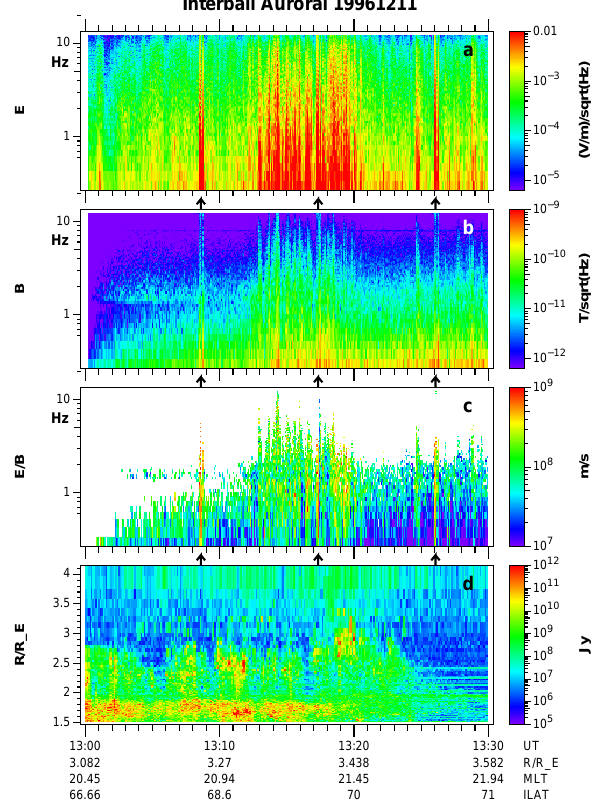
UT1.522.533.54 E R _ R / Fig. 8. Dot-AKR example event 11 December 1996 with IESP and POLRAD data, showing ( a ) electric IESP wave amplitude, ( b ) magnetic IESP wave power, ( c ) the E/B ratio from IESP and ( d ) POLRAD AKR data. Artificial signals are shown by arrows. The intensity in panel (d) is in Jansky (1 Jy = 10 − 26 W m − 2 Hz − 1 ). The vertical axis in panel (d) is the radial distance corresponding to the AKR frequency assuming the frequency corresponding to the lo- cal electron gyrofrequency. The dot-AKR seen at 13:18–13:20 at ∼ 3 R E radial distance (45–70kHz) occurs together with electro- magnetic low-frequency wave activity. Dots at 13:02, 13:07–13:08 and 13:10–13:12 are not associated with low-frequency waves. No- tice that perfect temporal correlation is not expected because